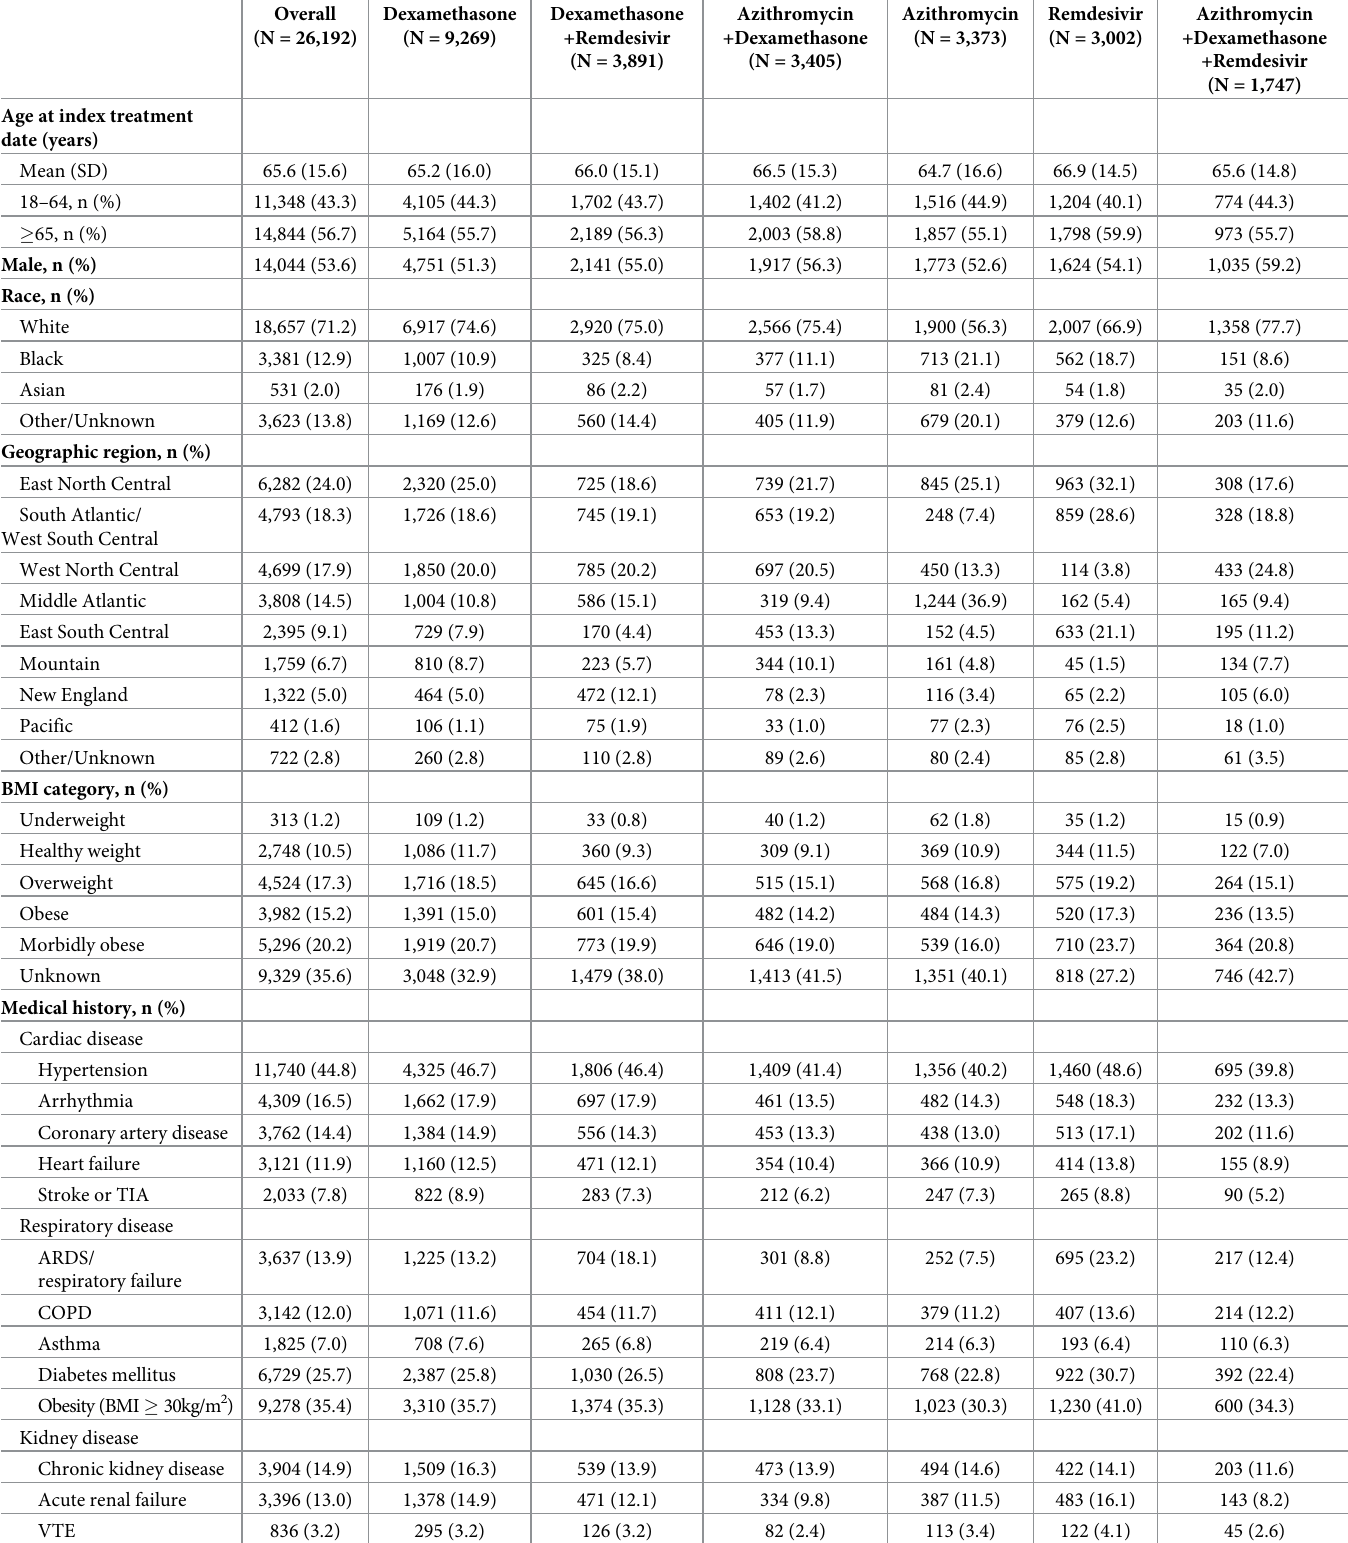
Table 1. Pre-treatment patient